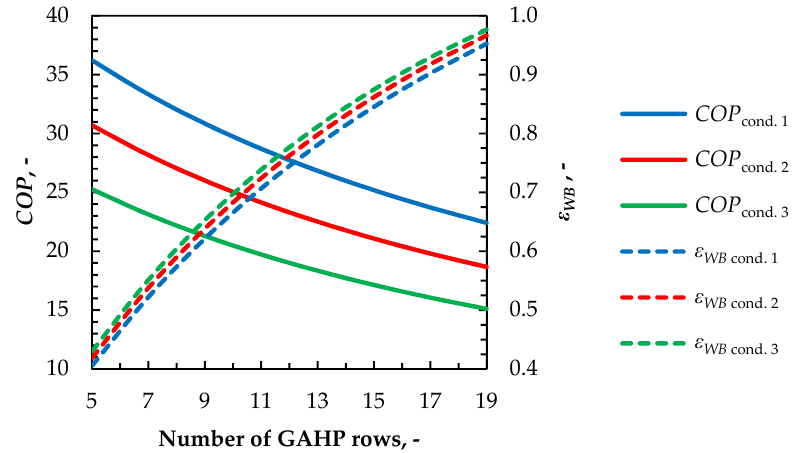
Figure 10. Impact of number of GAHP rows on the COP coefficient and wet bulb effectiveness.